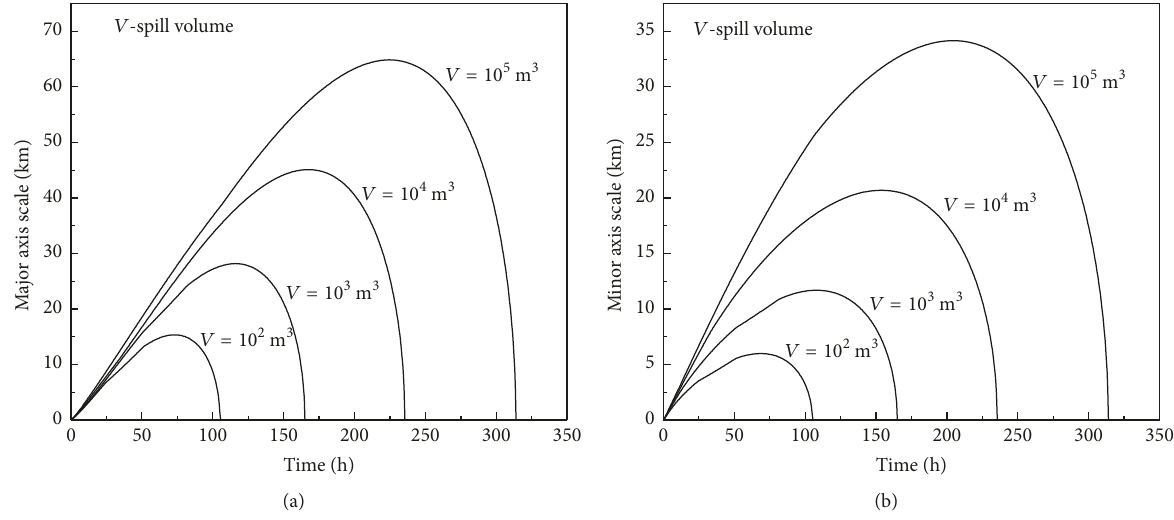
Figure 6: The major (a) and minor (b) axes of the oil slick versus time.